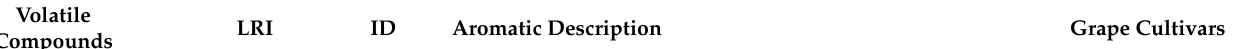
Table 1. Volatile compounds determined in the grape cultivars analyzed at their commercial maturity (D4). Data are expressed in relative area (abundance) with respect to the internal standard.